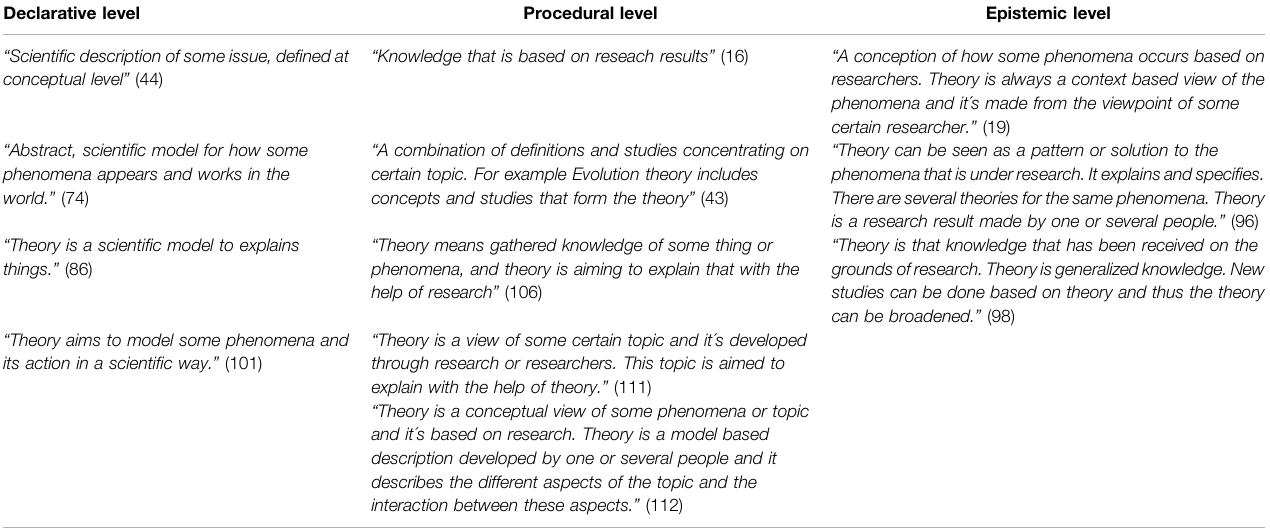
TABLE 2 | Examples of students ’ answers in the categories declarative, procedural and epistemic level. Declarative